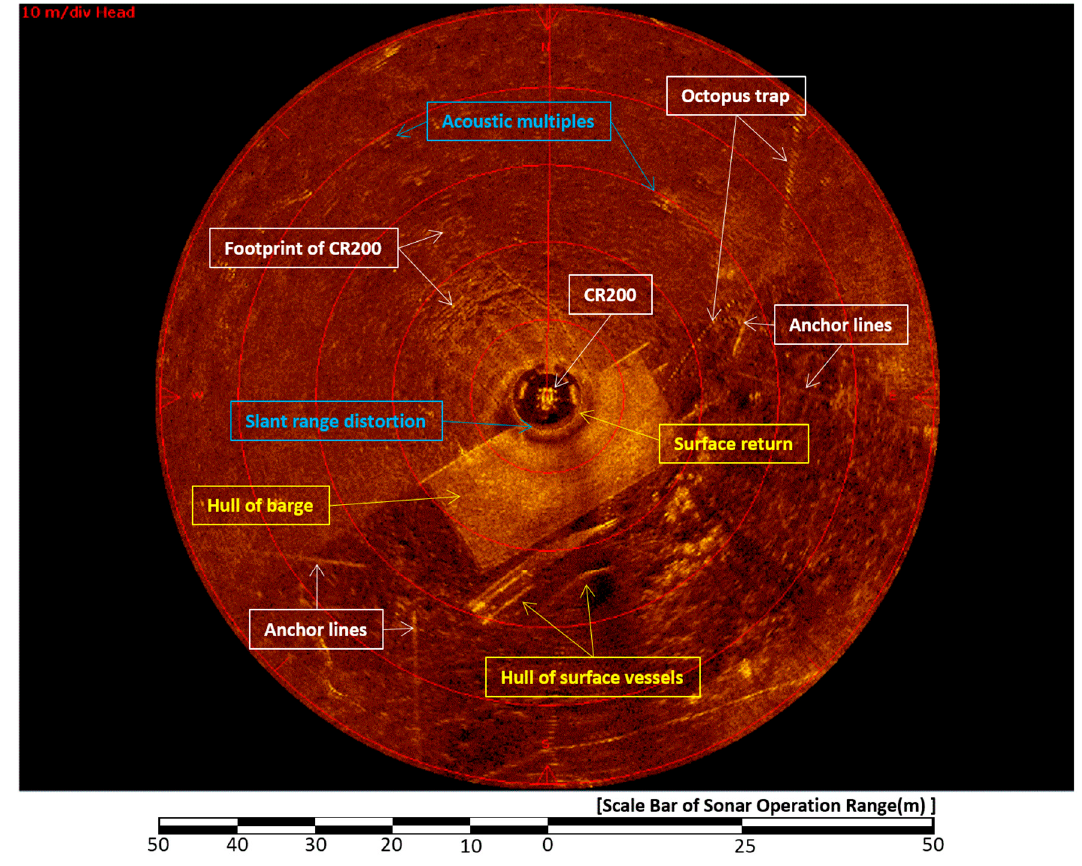
Figure 16. Sonar image of the CR200 in the first sea trial [32].